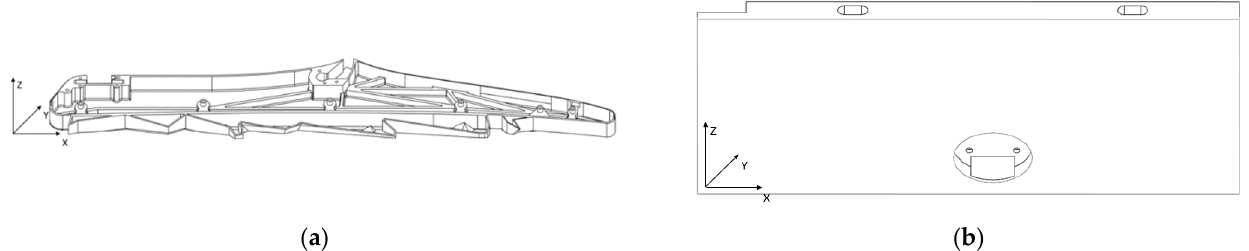
Figure 1. Printing directions for the class divider ( a ) and seat folding table ( b ). Table 3. Manufacturing parameters for the spare